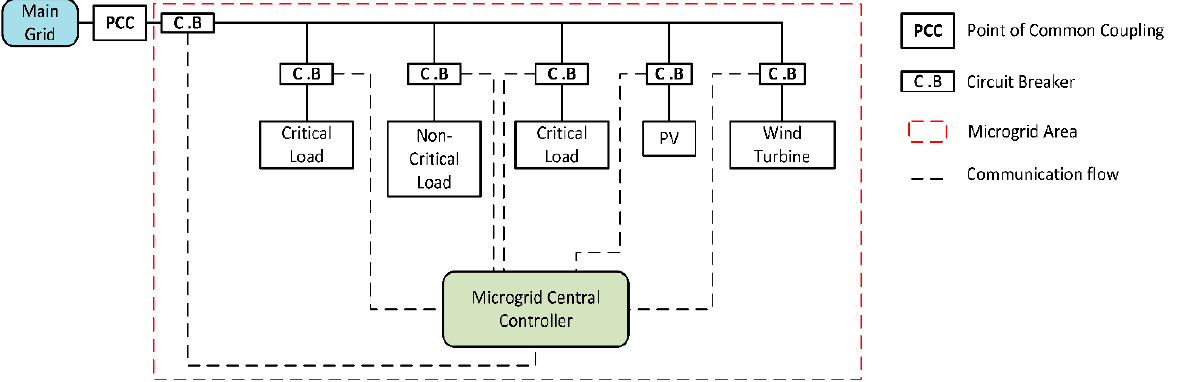
Figure 4. Block diagram of critical and non-critical loads connected with MGCC.